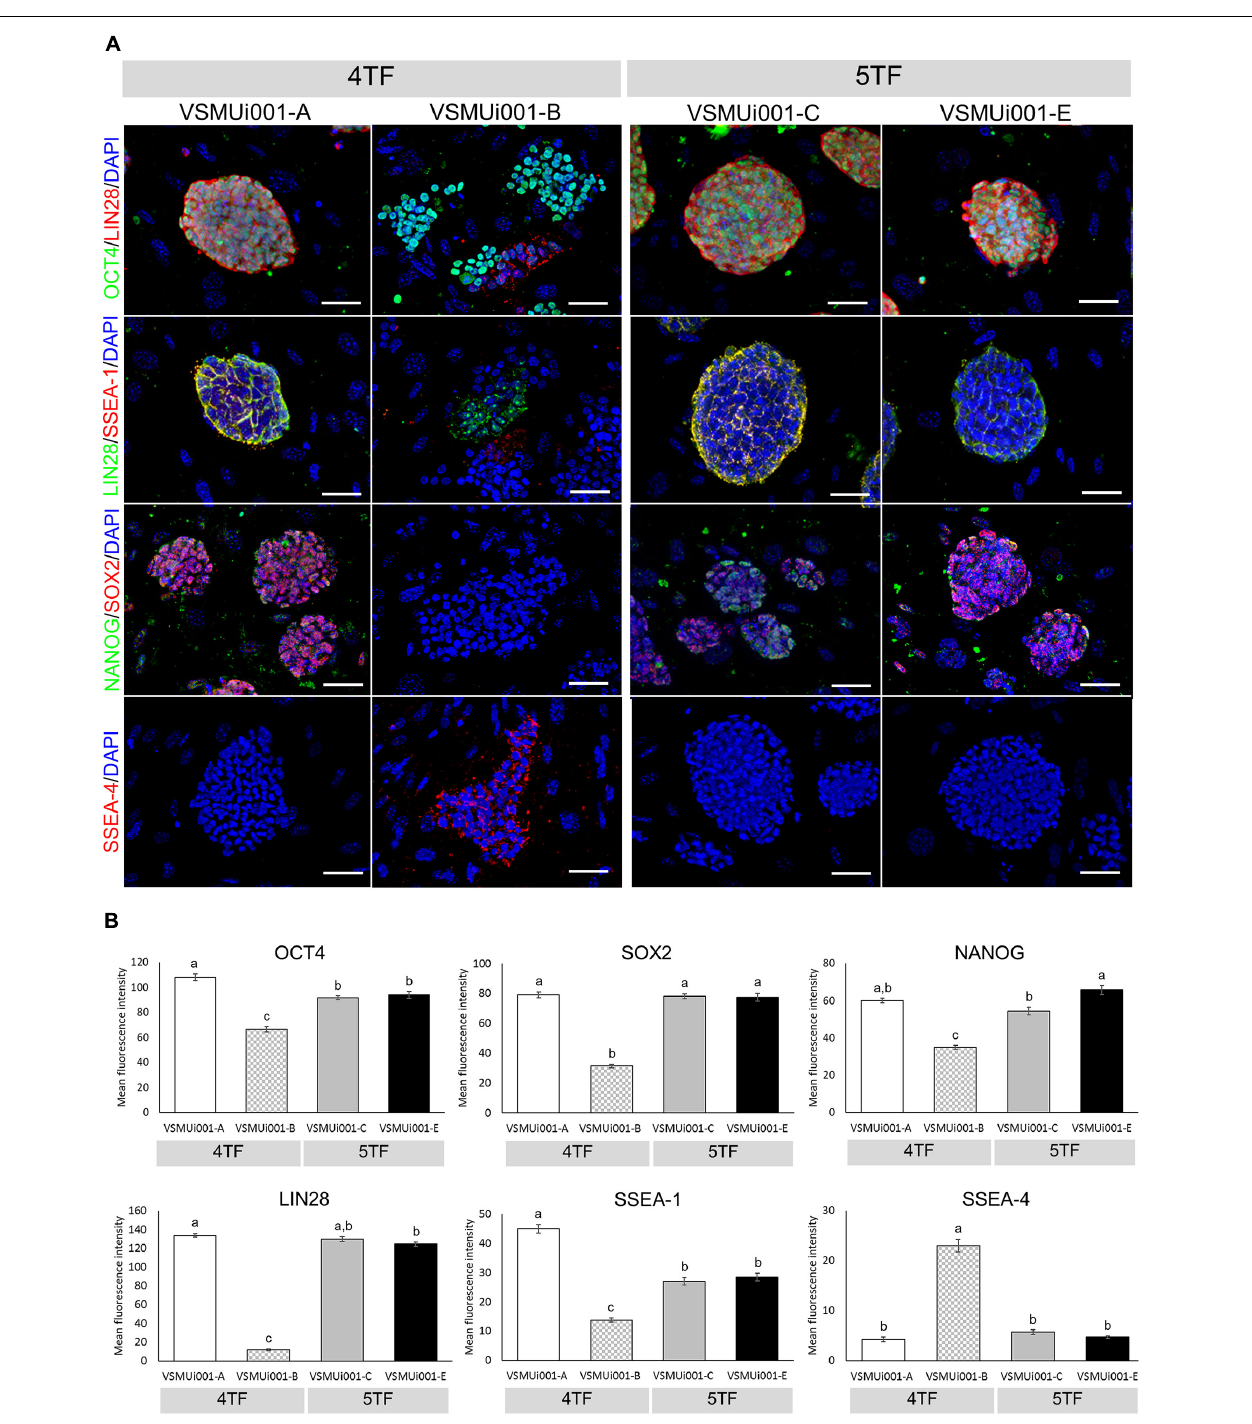
FIGURE 4 | Immunofluorescence analysis of pluripotency markers in various piPSC lines. (A) Detection of pluripotency markers in 4TF-piPSC and 5TF-piPSC lines using fluorescence microscopy; scale bar: 50 µ m. (B) Quantitative analysis of the pluripotency markers in the various piPSC lines. The mean fluorescence signals for OCT4, SOX2, LIN28, NANOG, SSEA-1, and SSEA-4 were measured in 20 randomly selected fields per piPSC colony under identical optical settings. Means with different lowercase letters are significantly different at P < 0.05. 4TF, induction using OCT4, SOX2, KLF4, and C-MYC; 5TF, induction using OCT4, SOX2, KLF4, C-MYC, and LIN28. OCT4, octamer-binding transcription factor 4; SOX2, SRY-box transcription factor 2; LIN28, Lin-28 homolog A; NANOG, Nanog homeobox; SSEA, stage-specific embryonic antigen.